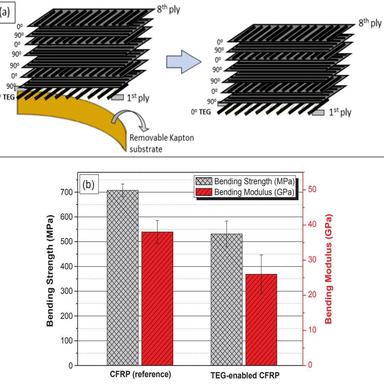
(a) Illustration of the Kapton substrate detachment before performing the three-point bending tests in order not to affect the mechanical properties of the TEGenabled CFRP, and (b) Bending strength and bending modulus with the corresponding standard deviations of the reference 8-ply 2s symmetric CFRP compared to the TEG-enabled one.